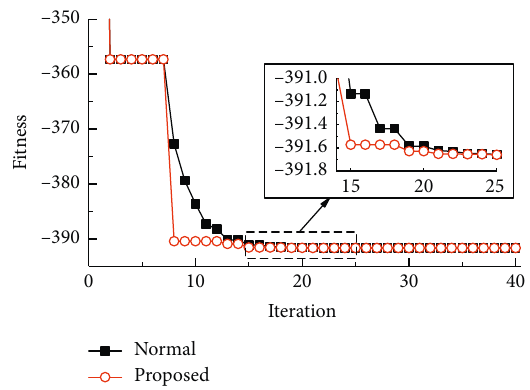
Figure 3: Convergence curve of the polynomial accumulation